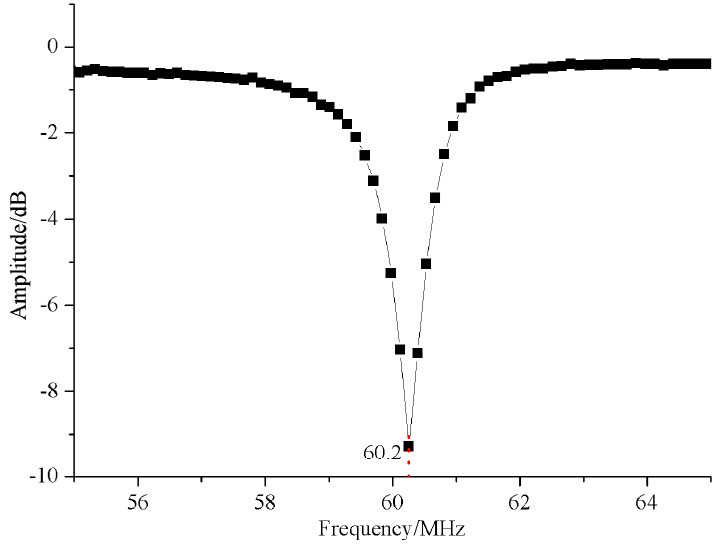
Figure 9. Scheme of the capacitive-loaded coaxial cavity in the Overhauser sensor.